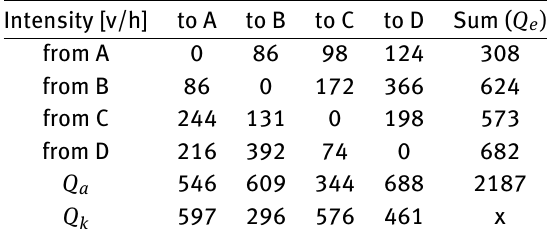
Table 2: Intensities on the round surface. Source: authors.